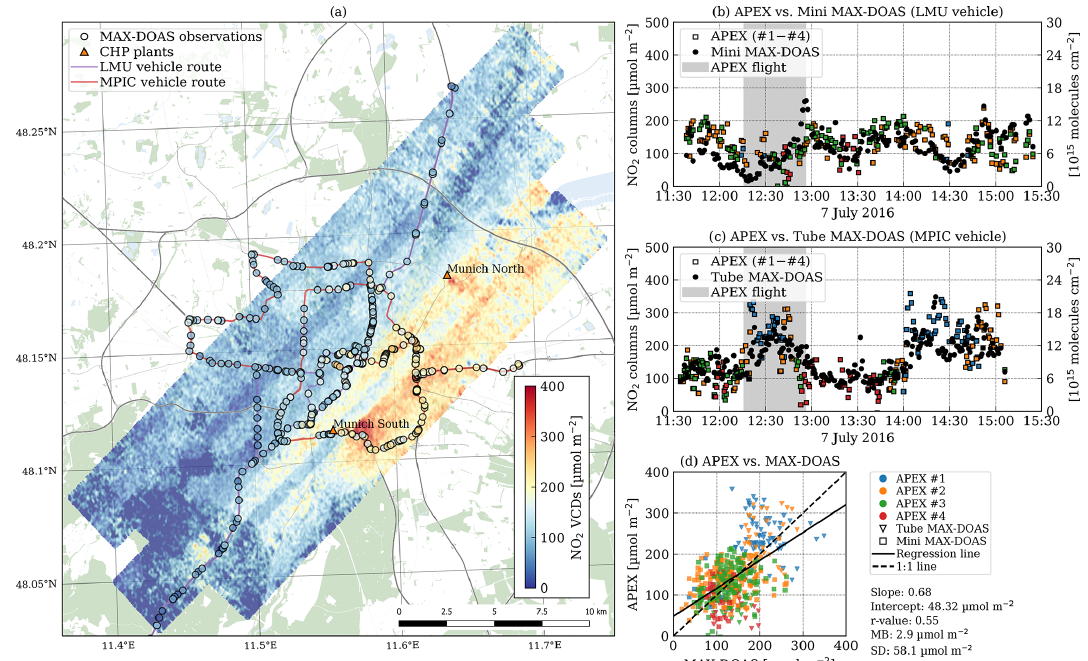
Figure 9. (a) Map NO 2 VCDs from APEX and mobile MAX-DOAS measurements on 7 July 2016 (afternoon). (b, c) Time series of spatially co-located APEX and (b) Mini MAX-DOAS and (c) Tube MAX-DOAS VCDs. (d) Scatter plot showing MAX-DOAS and APEX NO 2 VCDs for spatially co-located observations. Map data from © OpenStreetMap contributors 2021. Distributed under the Open Data Commons Open Database License (ODbL)